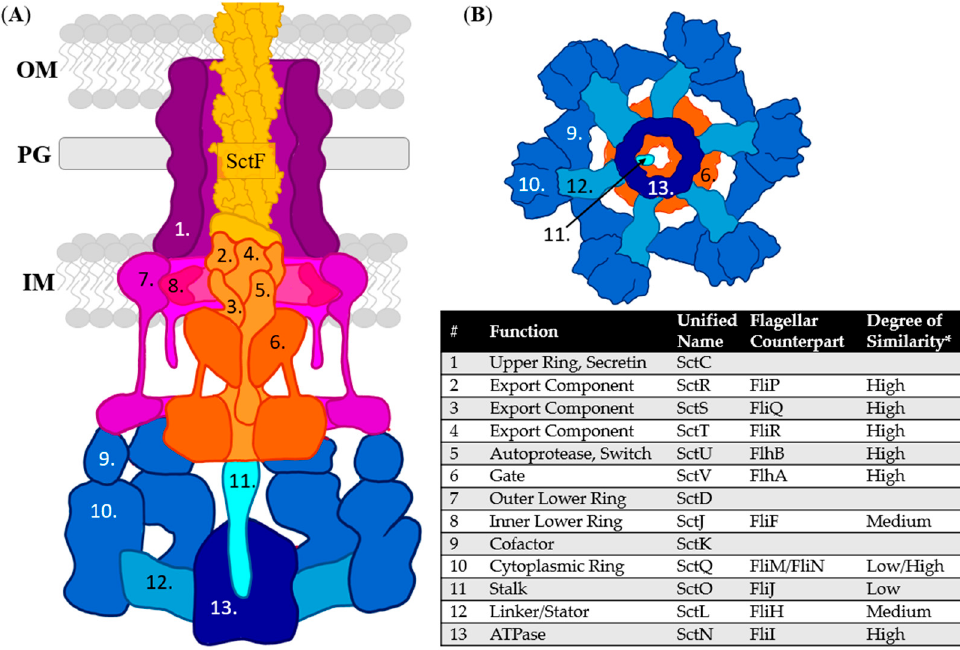
Figure 9. Structure of the T3SS basal body, export apparatus, and cytoplasmic complex with a list of unified protein names and functions. ( A ) Vertical section of the T3SS basal body and sorting platform. ( B ) A bottom-up view of the T3SS sorting platform. Abbreviations: OM, outer membrane; PG, peptidoglycan; IM, inner membrane. *Degree of similarity between flagellar and injectisome components in Y. enterocolitica : high, E < 10 − 5 ; medium, 10 − 5 < E < 0.01; low, E > 0.01 [155].